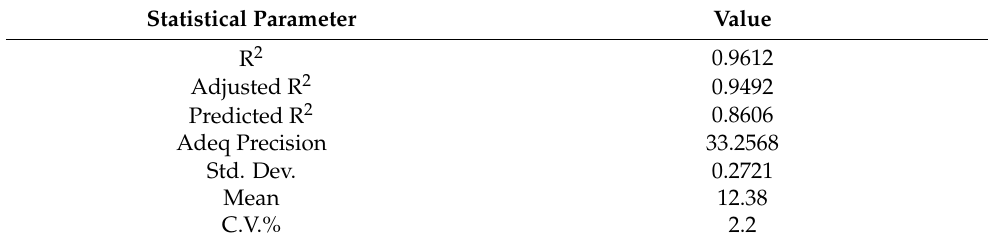
Table 10. Fit statistics.